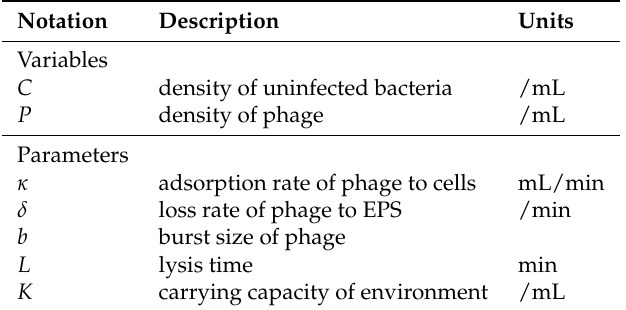
Table 4. Model variables and